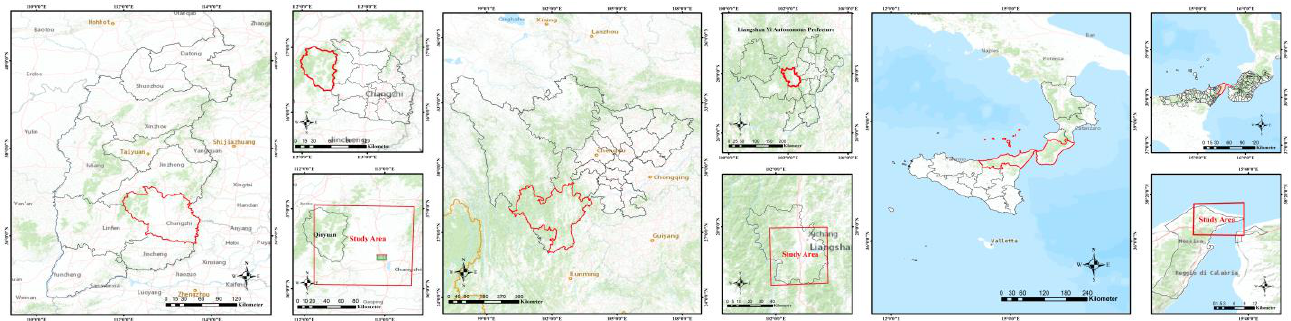
Figure 1. Locations of the three study areas, from left to right, are Qinyuan County, Shanxi Province, China, Xichang City, Sichuan Province, China and Sicily Island, Italy.